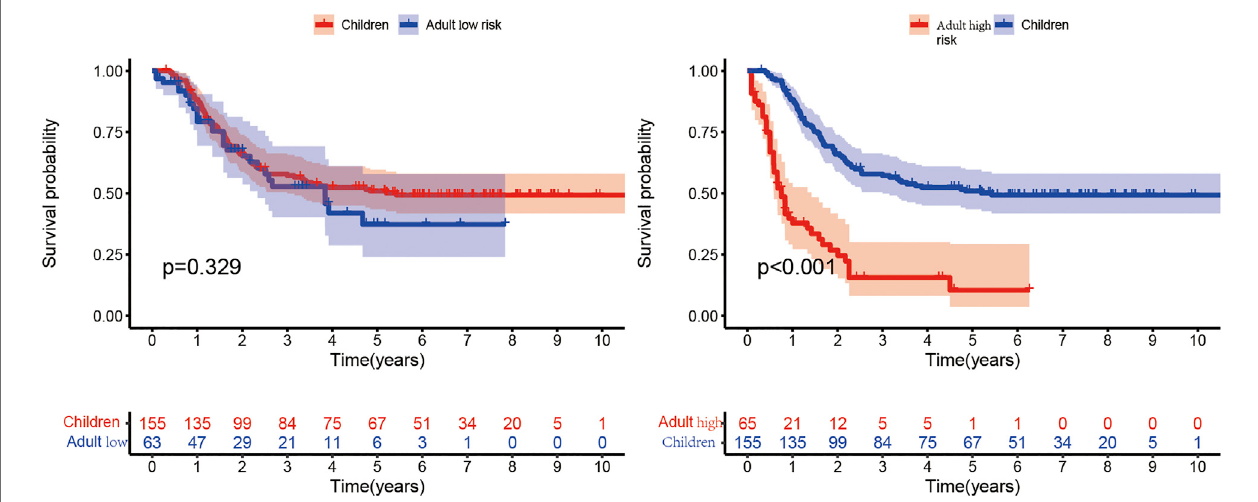
FIGURE 10 | Comparison of the children group from the TARGET database with the high- and low-risk subgroups of the adult group. In the Kaplan – Meier curve, the X- and Y -axes represent the time and probability of survival, respectively.